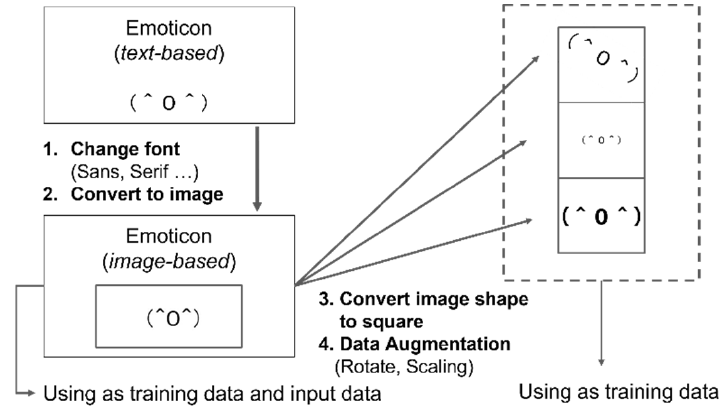
Figure 3. The emoticons to images conversion